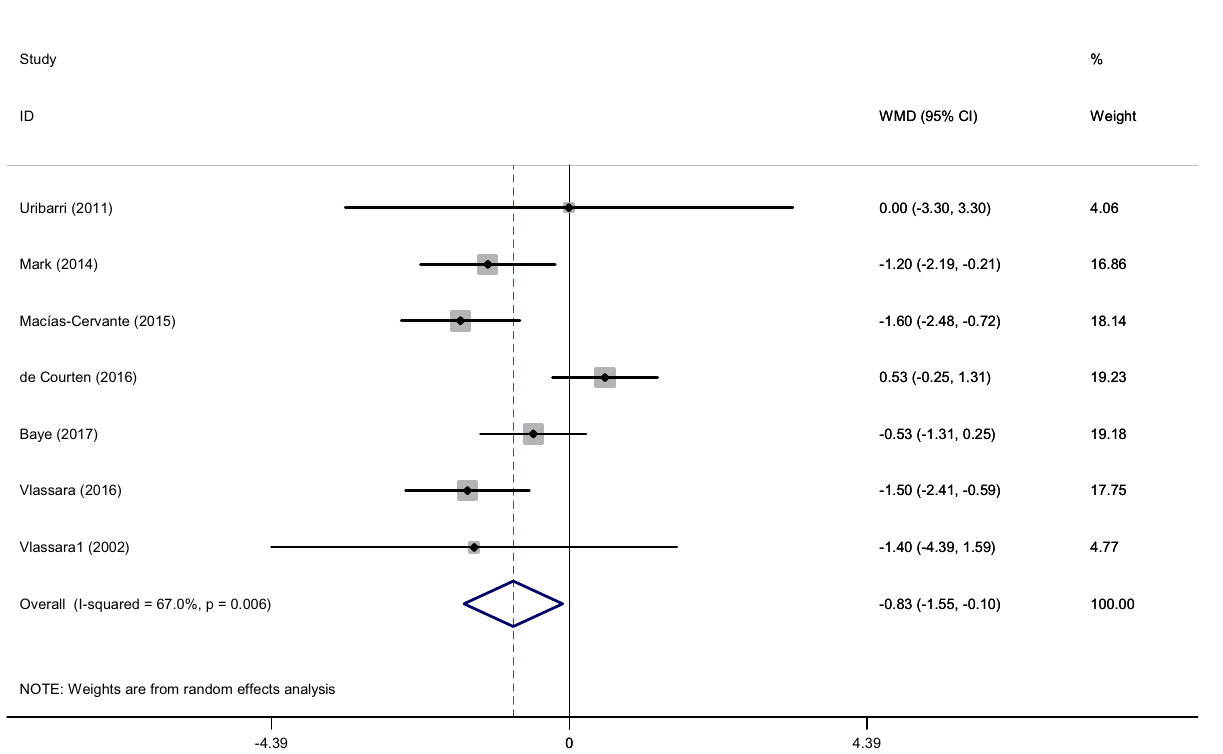
Figure 3. Forest plot of randomized controlled trials investigating the effects of low dietary AGEs on